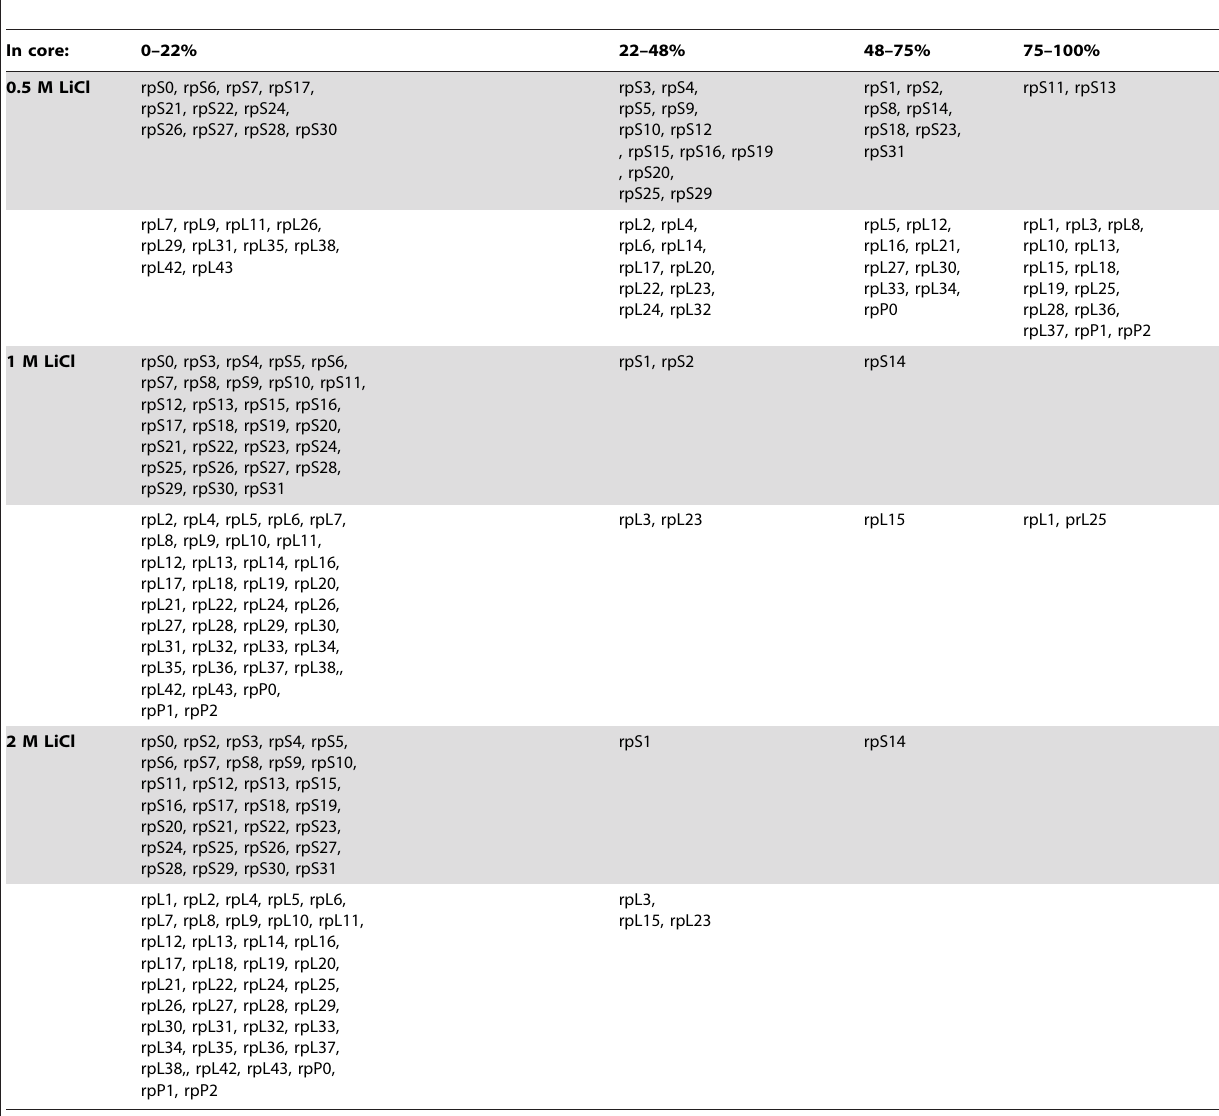
Table 1. Grouping of yeast r-proteins according to fraction of each protein in the ribosomal core at given LiCl concentration.